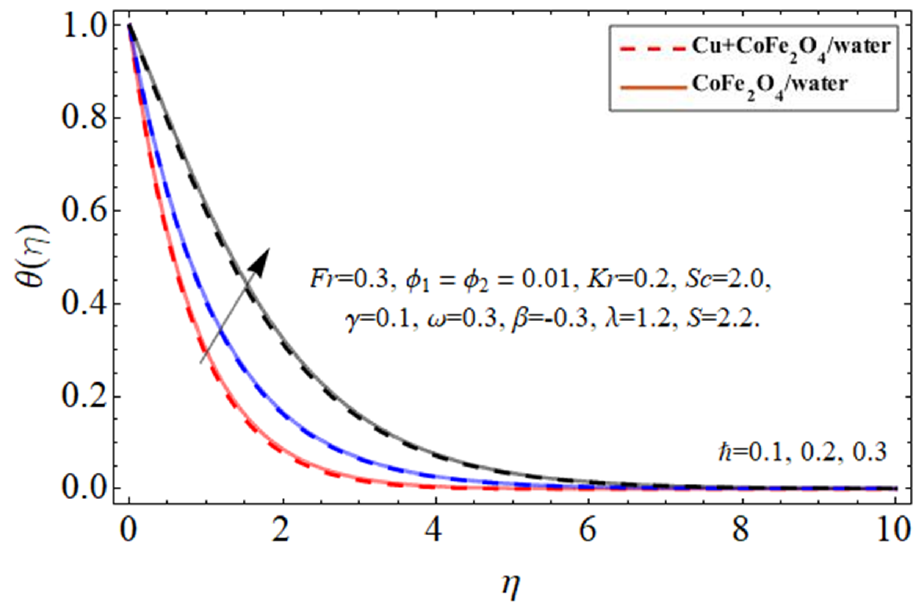
( ) θ η ( ) θ η versus heat absorption/generation term  . versus heat absorption/generation term  .